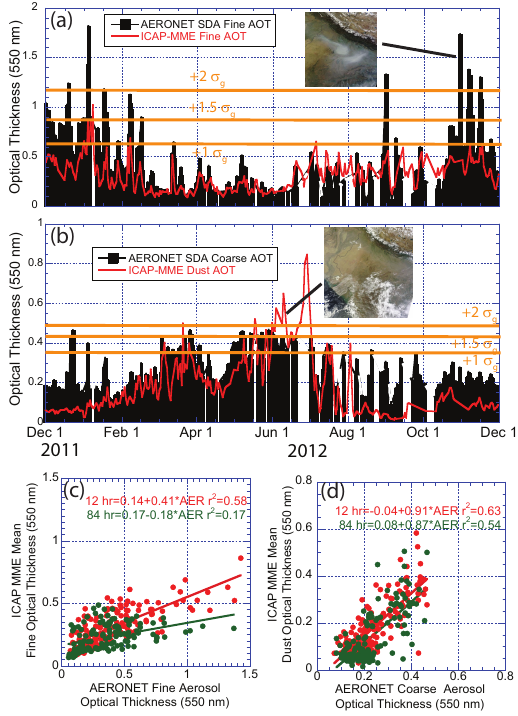
Figure 12. An example of the derivation of threat scores for the CapeV site. (a) One-year time series of first-day forecasted ICAP- MME mean AOT with corresponding AERONET coarse mode AOT. Insets are MODIS RGB images for an actual and artifact dust event. (b) enlargement of (a) for the month of May 2012; (c) scat- terplot of forecasted AOT against AERONET; (d) probability dis- tribution of AERONET and forecasted